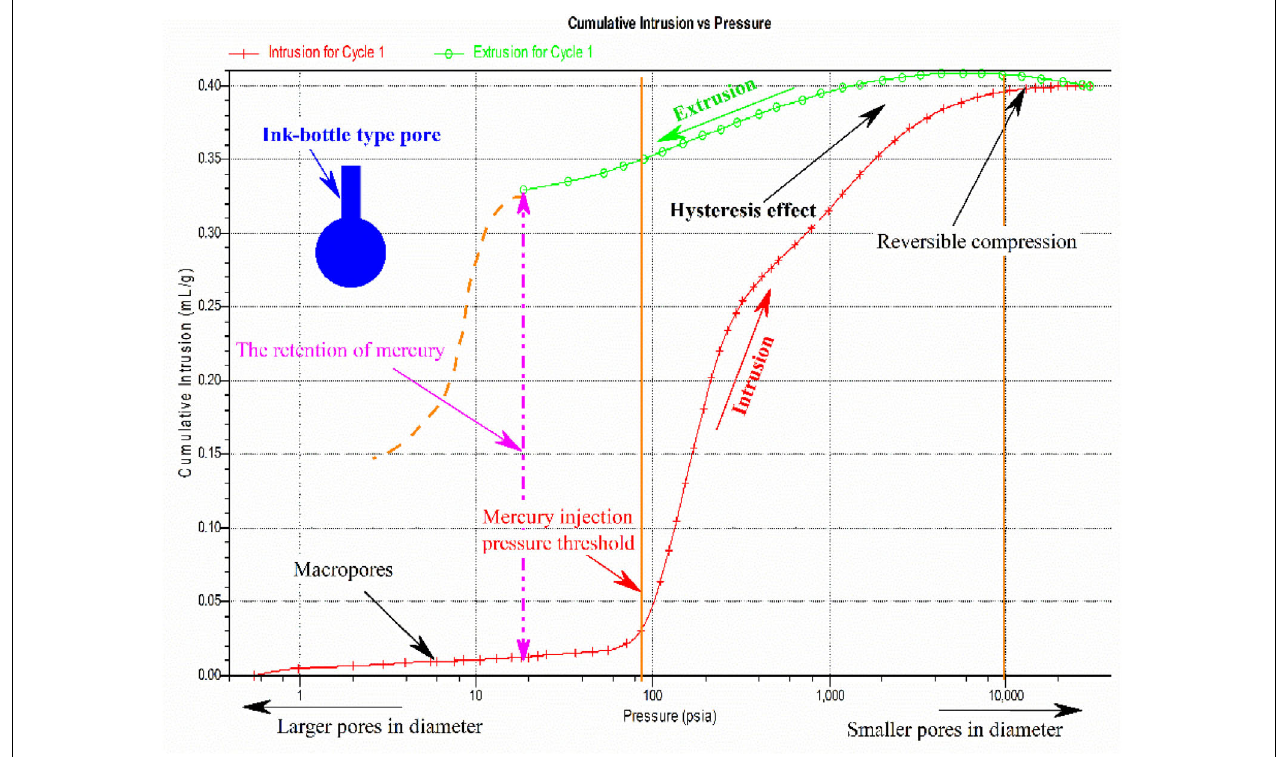
FIGURE 7 | Overall observation of the mercury intrusion